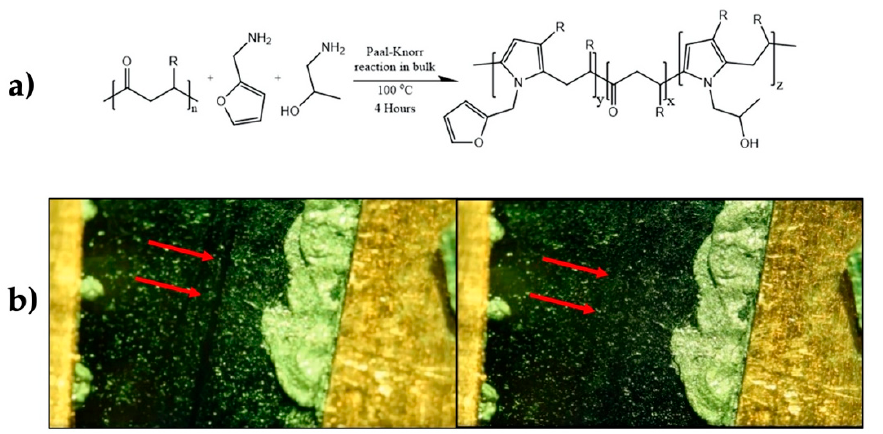
Figure 8. ( a ) Chemical structure of polymer used to prepare composites bearing Diels-Alder functional groups. ( b ) Optical images of self-healing by Joule effect [91]. Adapted with permission from Lima, G.M.R, Polymers; published by MDPI, 2019.